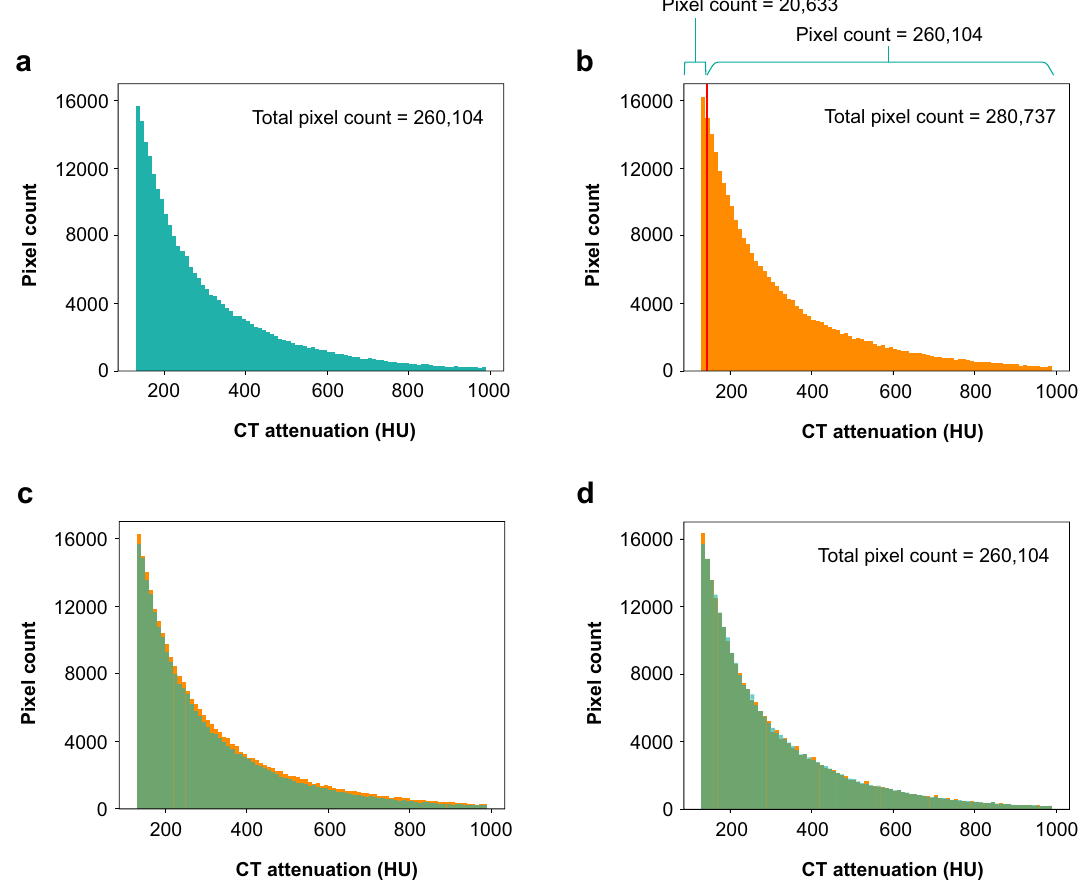
Figure 1. Histogram matching using the cumulative distribution function to obtain modified thresholds for 100 kV. The 120 kV histogram showed CT numbers of 130 HU through 1887 HU for 260,104 pixels from coronary calcium ( a ). The 100 kV histogram demonstrated 280,737 pixels with CT numbers from 130 HU to 2059 HU ( b ). The overlapping two histograms ( a , b ) showed more pixels from 100 kV images ( c ). After excluding 20,633 pixels (280,737 – 260,104 = 20,633) from the 130 HU of the 100 kV histogram, the two histograms were almost identical ( d ). Afterwards, we found matching points in the 100 kV